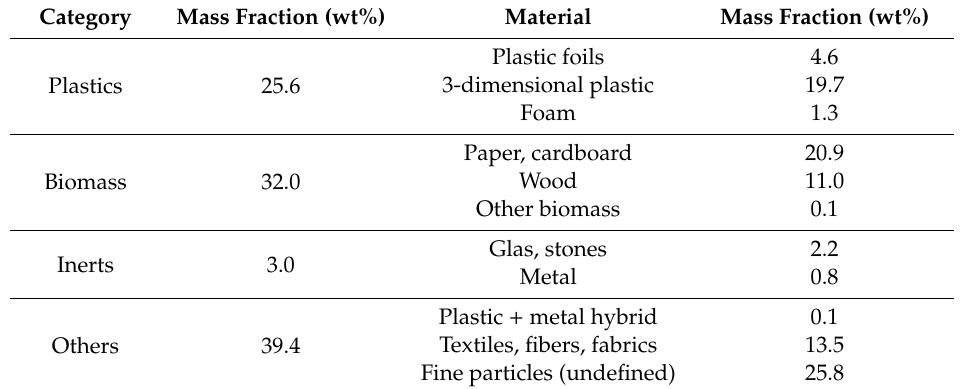
Table 5. Manual sorting of RDF flu ff .